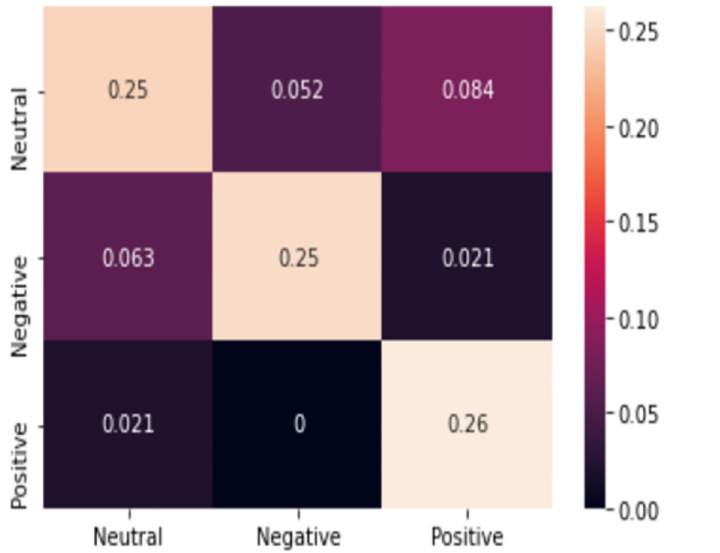
Fig 2. Confusion matrix. The confusion matrix of the sentiment analysis model.